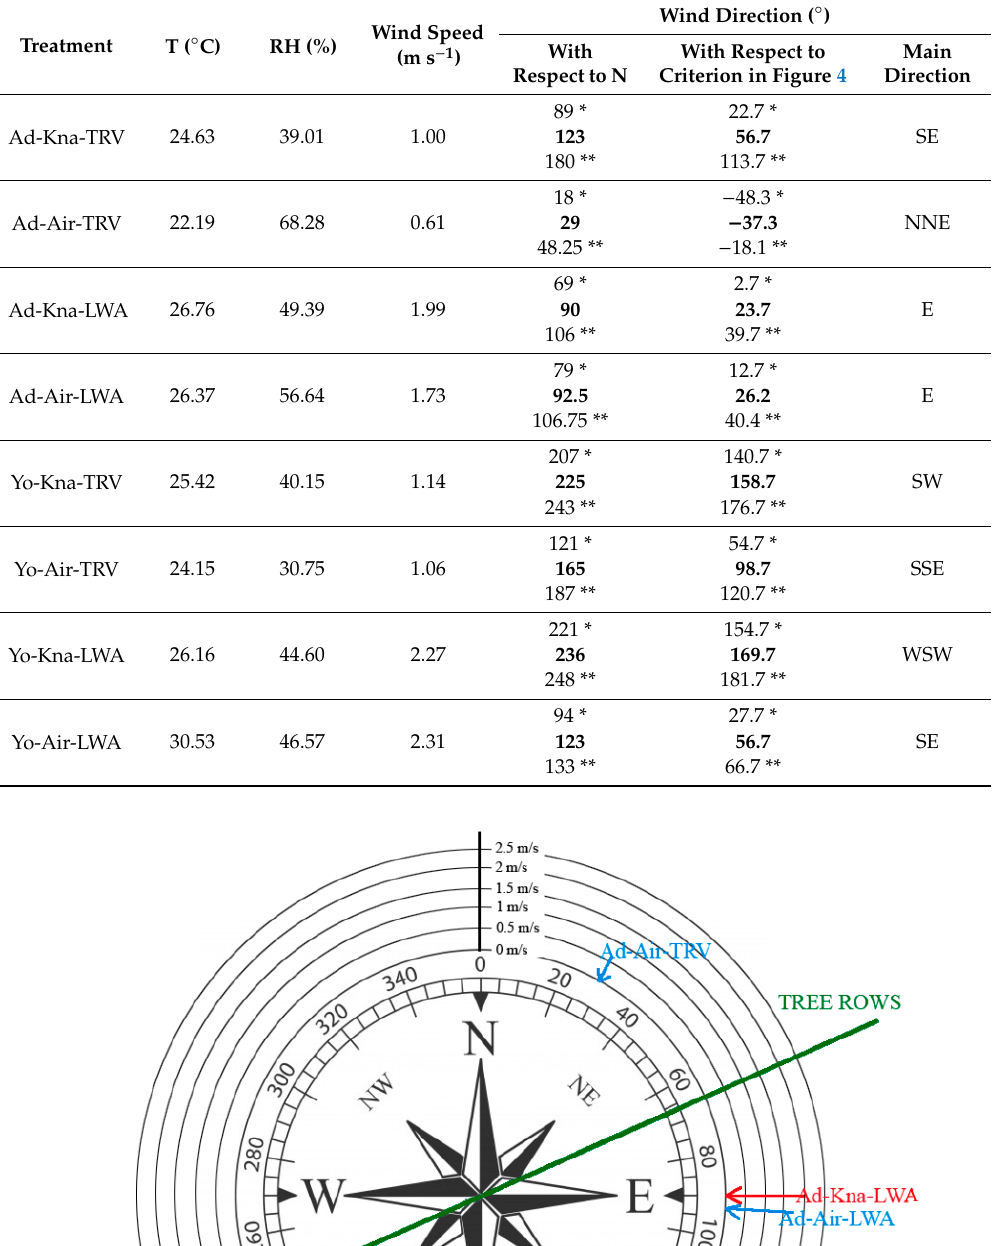
Table 5. Mean temperature, relative humidity, and wind speed during treatments. For wind direction, the 25th percentile (*), 50th percentile (median) (in bold), and 75th percentile (**) are indicated.